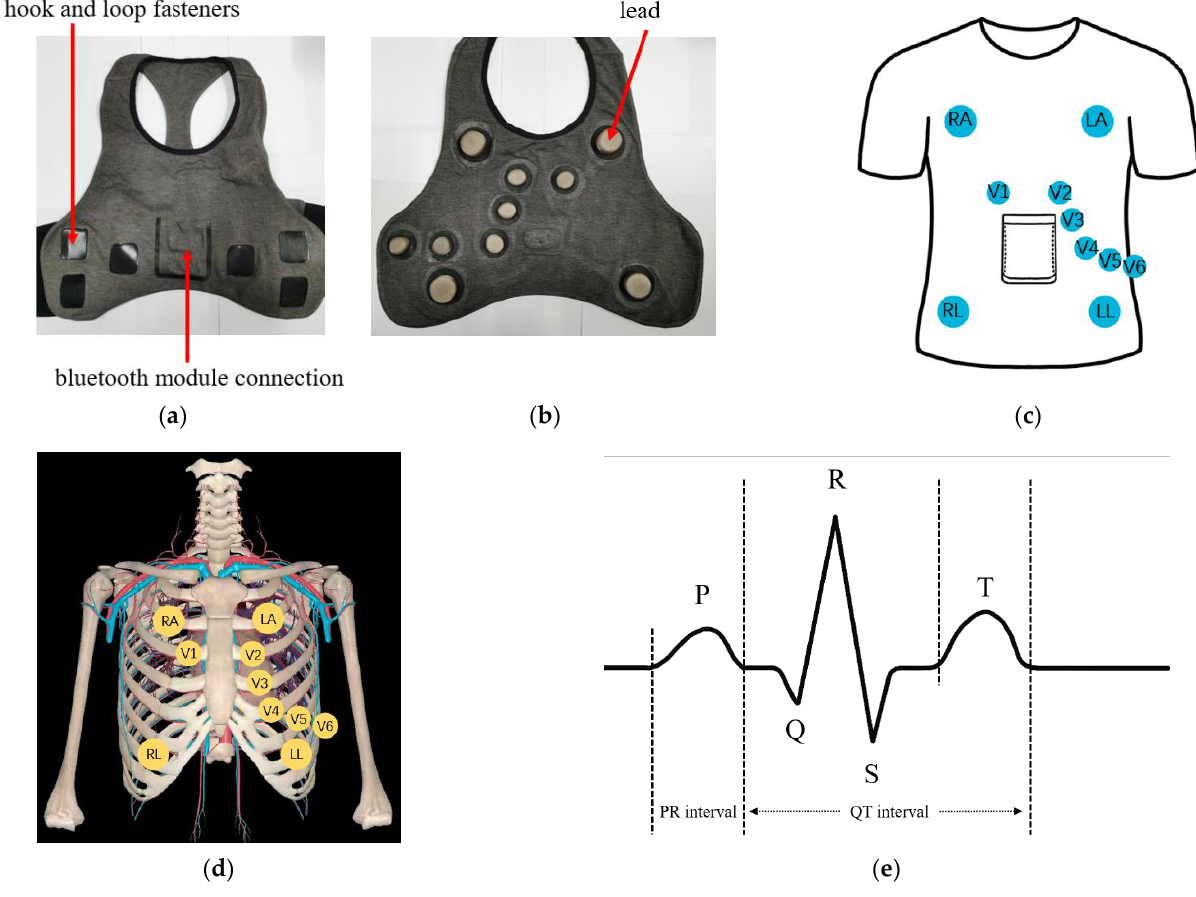
Figure 5. ( a – c ) show the basic structure of electrocardiogram, ( d ) shows the position of human body corresponding to lead of electrocardiogram, and ( e ) shows ideal